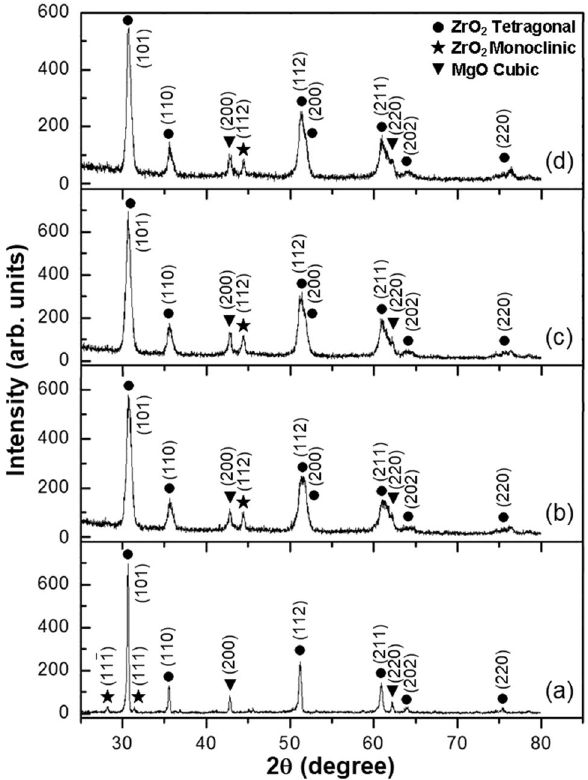
Figure 2. XRD patterns of the as-sprayed MSZ coating in ( b ), ( c ), and ( d ) with plasma spraying input currents compared with the MSZ powder in ( a ). Coatings in ( b ), ( c ), and ( d ) were corresponding to samples ZM1, ZM2, and ZM3, which were carried out at plasma spraying current of 600, 650, and 700 A,